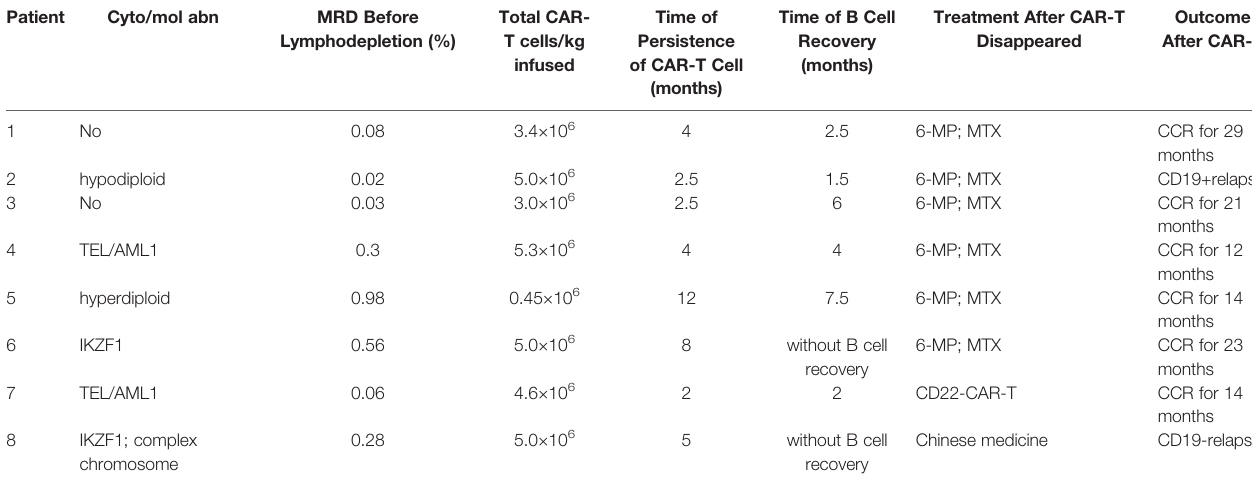
TABLE 3 | Clinical features and outcomes of patients who did not bridge to allo-HSCT after CAR-T therapy. Patient